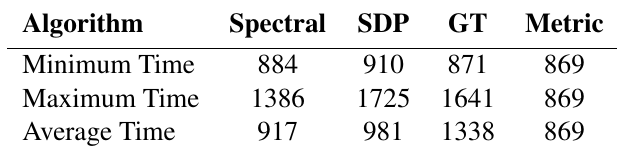
Table 5. Comparison of our approaches with other best methods in terms of